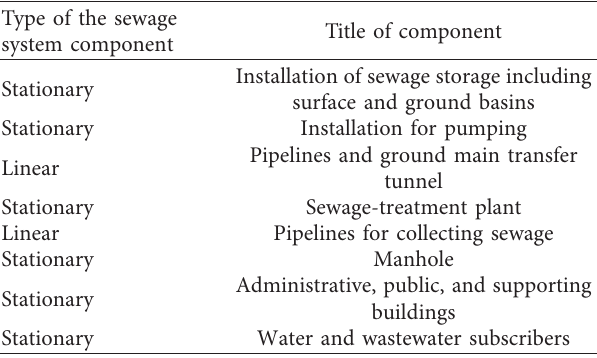
Table 1: Classification of the sewage system parts into linear and